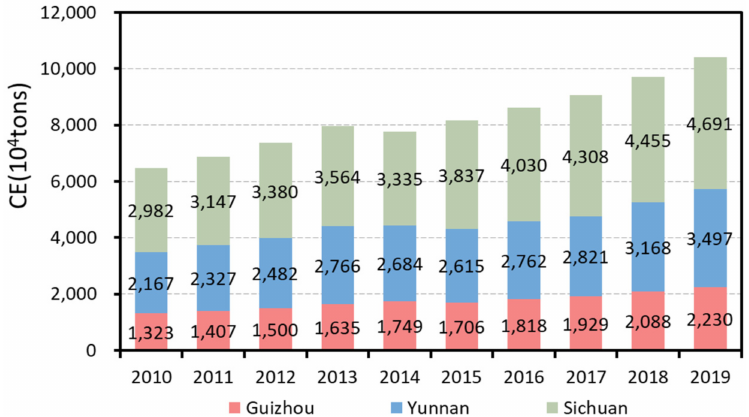
Figure 6. Carbon emissions from transportation and postal